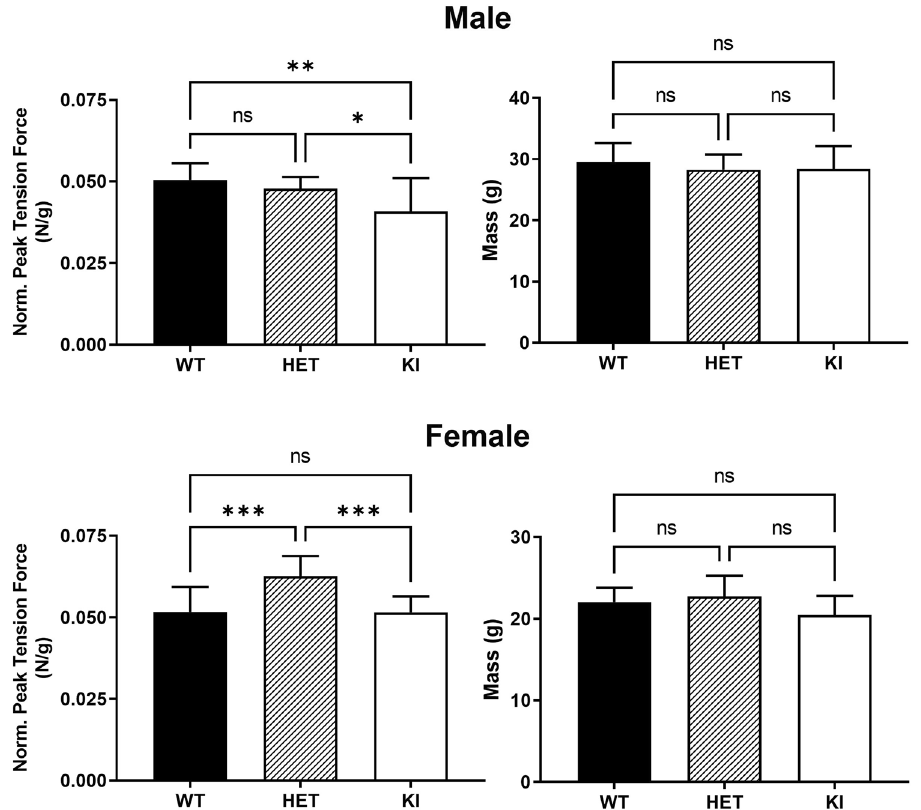
Figure 7. Reduced forelimb grip strength in male Gaa em1935C > A transgenic mice. Forelimb peak tension force and body mass measurements in 3-month-old male WT (n = 12; black bars), HET (n = 12; striped bars), and KI (n = 14; white bars) mice (top panel) and female WT (n = 12; black bars), HET (n = 12; striped bars), and KI (n = 11; white bars) mice (bottom panel). No significant difference in body weight in each gender cohort among WT, HET and ki groups. Male KI mice demonstrate decreased normalized peak tension force consistent with skeletal muscle weakness. Forelimb peak tension force was measured using a grip strength meter and taken as the average of 9 trials over 3 days. Data are shown as mean ± SD. All comparisons were analyzed using one-way ANOVA with the Tukey post-hoc test. * p < 0.05, ** p < 0.01, *** p < 0.001. ns: not